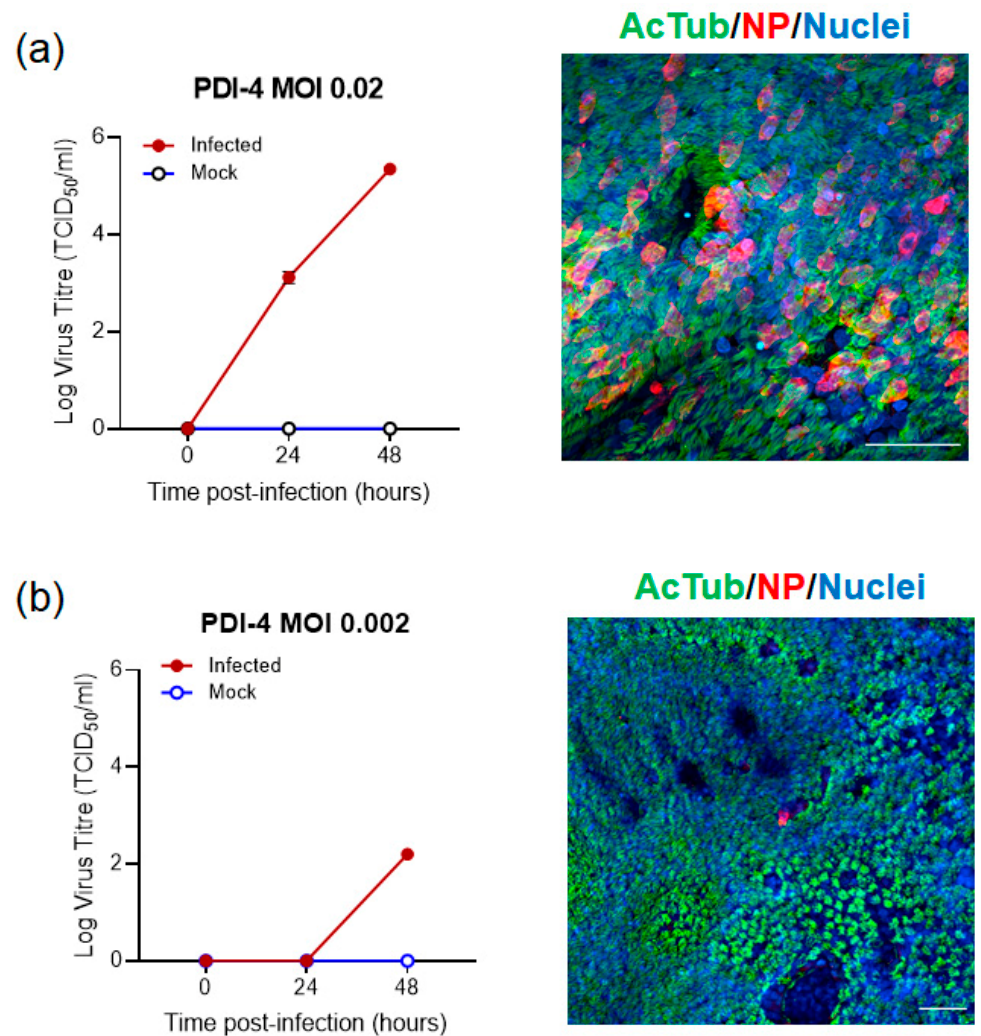
Figure 3. Dose dependent SARS-CoV-2 infection of ALI-HNE. ALI-HNE infected with VIC01 at MOI 0.02 ( a ) and 0.002 ( b ). Infectious virus (TCID 50 ) in the apical wash harvested at the indicated times; and immunofluorescent confocal microscopy staining for α -tubulin (AcTub, green) and nucleoprotein (NP, red). Nuclei are blue (DAPI). Scale bar 50 µm.